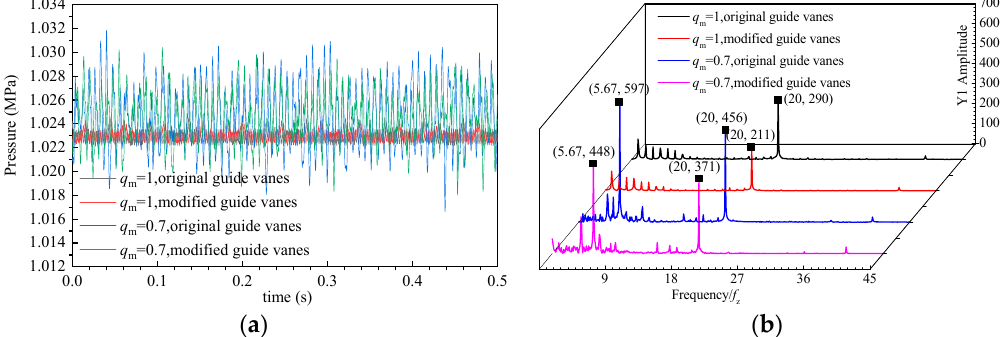
Figure 10. Comparison of the pressure pulsation at the Y1 monitoring point in the impeller. ( a ) Pressure time domain information; ( b ) Pressure spectrum.